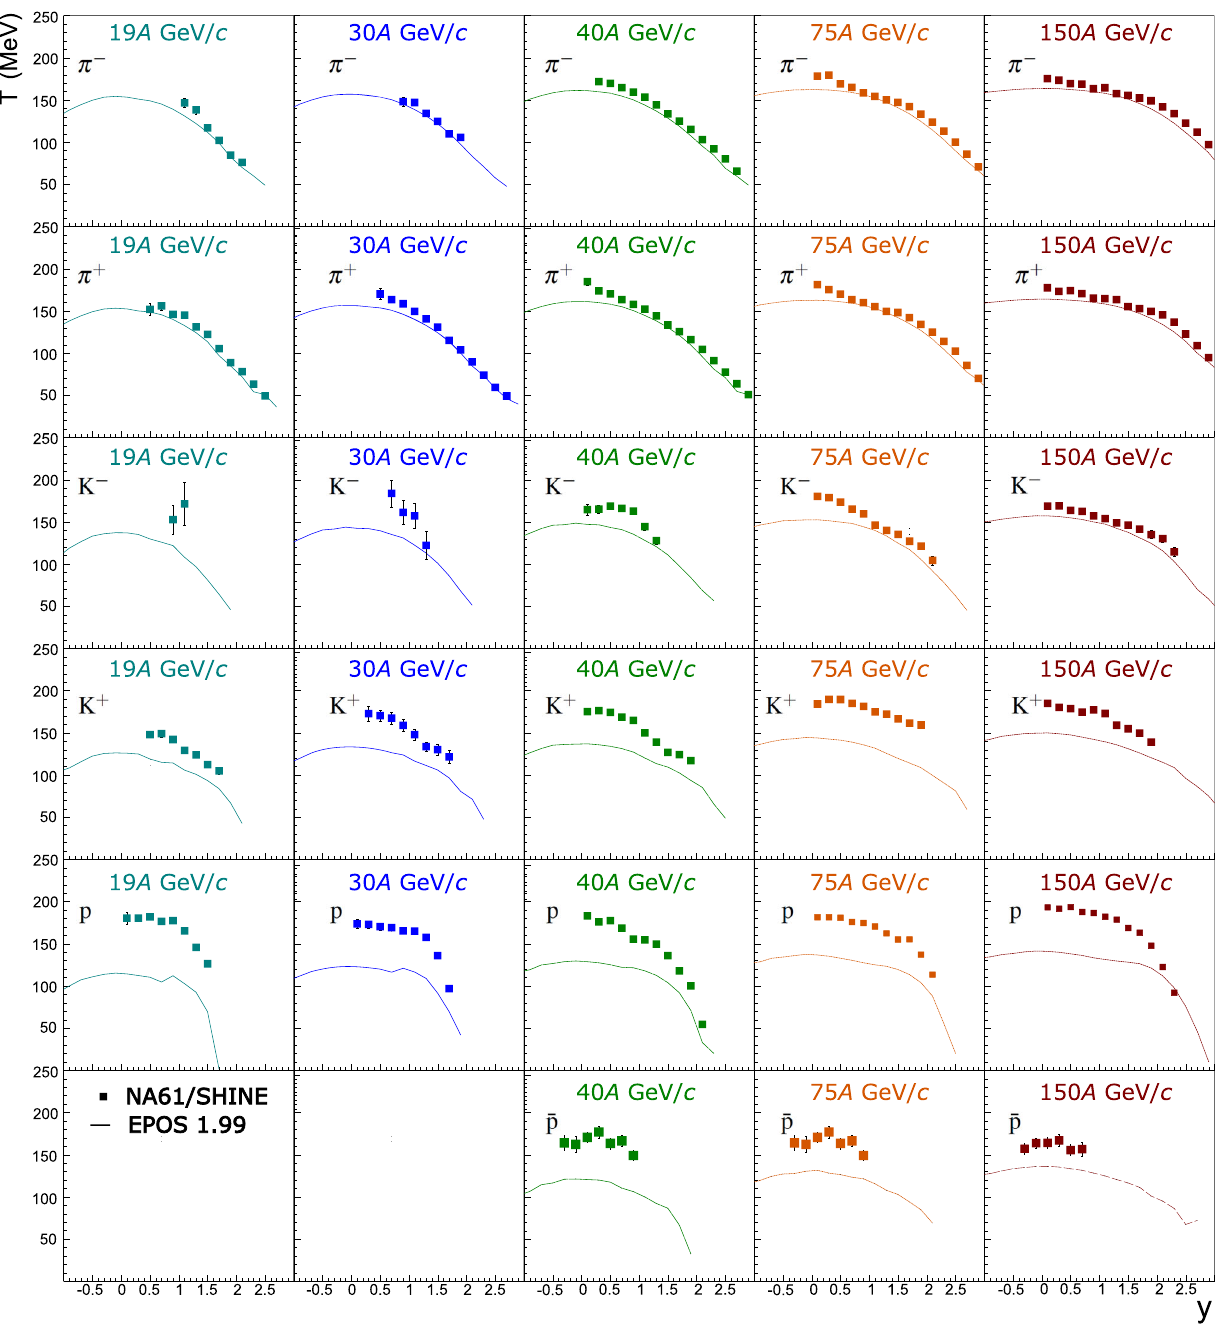
Fig. 28 Inverse slope parameter T of the p T distributions as func- tion of rapidity y fitted with Eq. (21) in the full available p T range. Results for the 20% most central Be+Be collisions at beam momenta